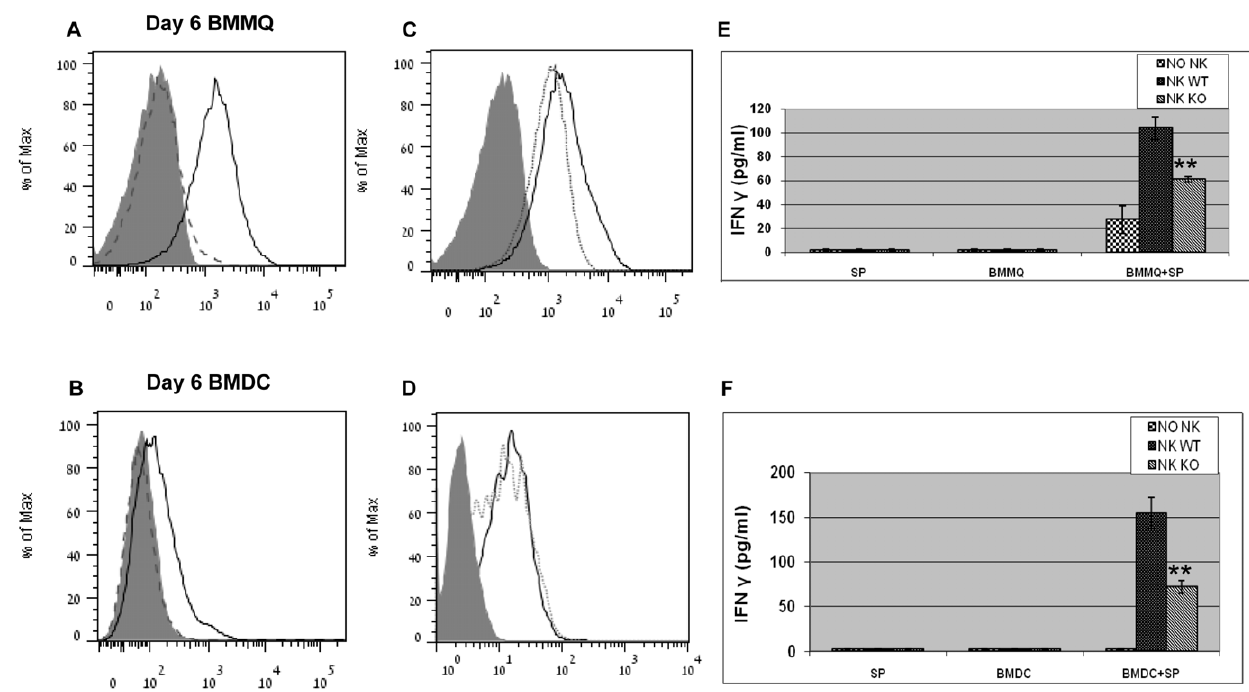
Figure 6. NCR1 involvement in NK cells activation following infection of BMMQ/ BMDC with S.pneumoniae. (A-D) Six-day culture of BMMQ and BMDC grown from Ncr1 + / + BM cells (C57BL/6) were stained with mNCR1-Ig, mNKG2D-Ig and LIR1-Ig fusion proteins. Shown are representative overlays of F4/80 + CD115 + BMMQ (A, C) and CD11c + BMDC (B, D) demonstrating staining with mNCR1-Ig (solid line, A-D), mNKG2D-Ig (dotted line, C–D), LIR1-Ig (dashed line, A–B) and with goat anti-human IgG (grey-filled, A–D). Shown is one representative experiment out of four to five independent experiments. In some experiments, NKG2D-Ig staining was higher compared to NCR1-Ig staining. (E–F) Six-day culture- BMMQ (E) and -BMDC (F) grown from Ncr1 + / + BM cells (C57BL/6) were infected with 1 MOI of S. pneumoniae for 1.5 h, then bacteria were removed and antibiotics were added. In parallel, NK cells were isolated from splenocytes of Ncr1 + / + (‘NK WT’) and Ncr1 gfp/gfp (‘NK KO’) C57BL/6 mice. Isolated NK were incubated with uninfected BMMQ or BMDC, or with S. pneumoniae -infected BMMQ or BMDC (‘BMMQ + SP’, ‘BMDC + SP’) after removal of bacteria for additional 18 hours. NK-BMMQ ratio was 1:4 and NK-BMDC ration was 1:10. IFN c concentration levels in the co-culture supernatants were determined by ELISA. Results are from one representative experiment out of two. ** p , 0.01 compared with IFN c levels of NK WT incubated with infected BMMQ/BMDC, 6 SD (ANOVA test).